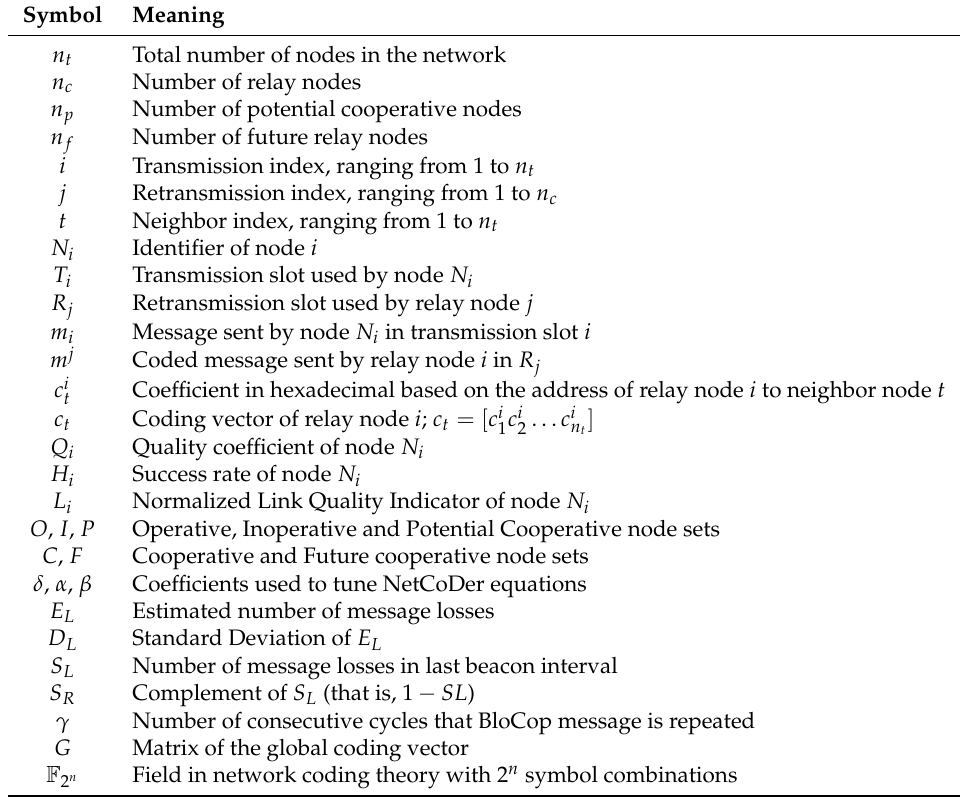
Table 1. Summary of